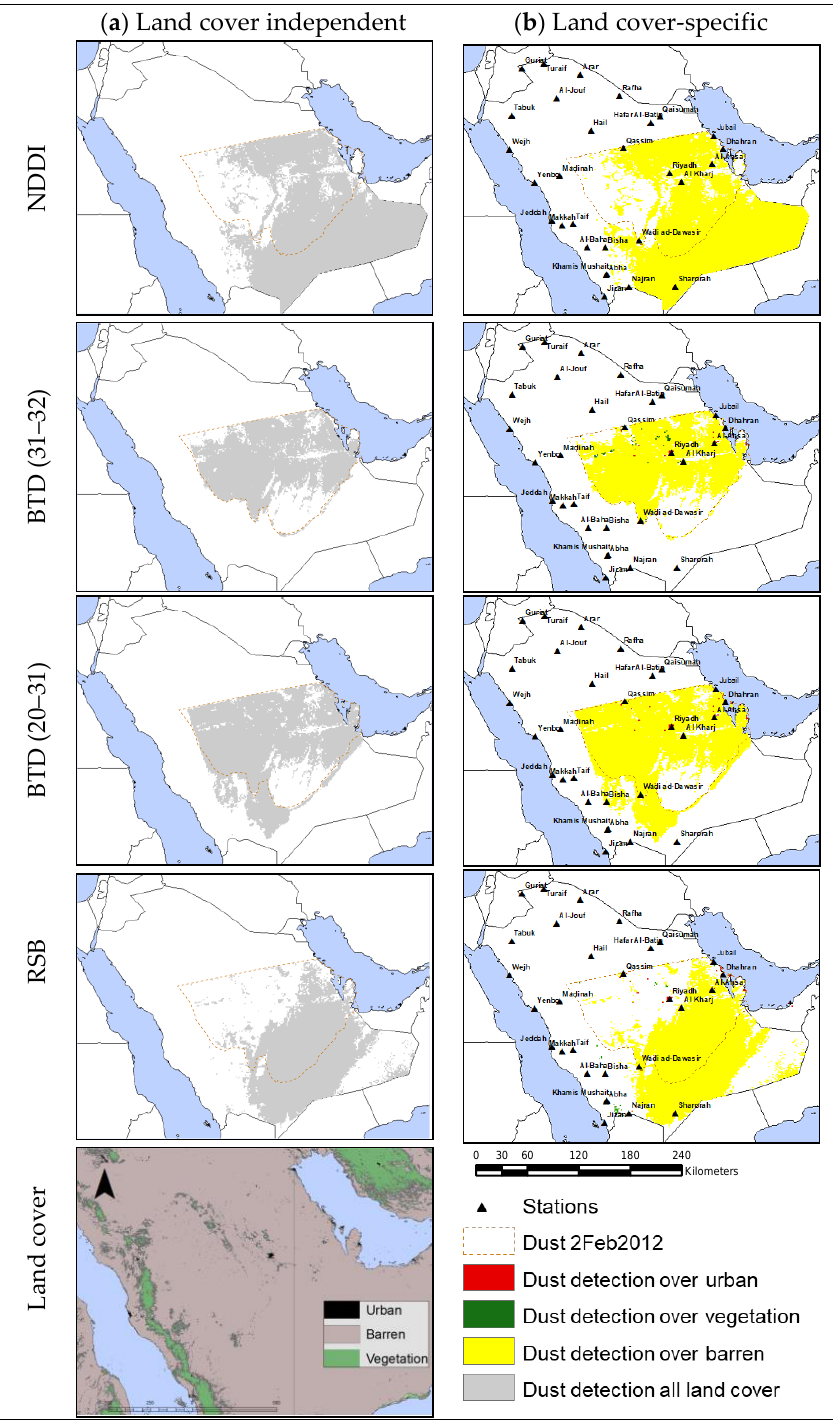
Figure 4. Validation results within subpanels ( a ) the detected dust-storm area irrespective of land cover types, and in subpanels ( b ) the detected dust-storm area using different threshold values for each land cover type (the dashed polygon indicates the extent of the dust-storm as detected on the RGB true color image).